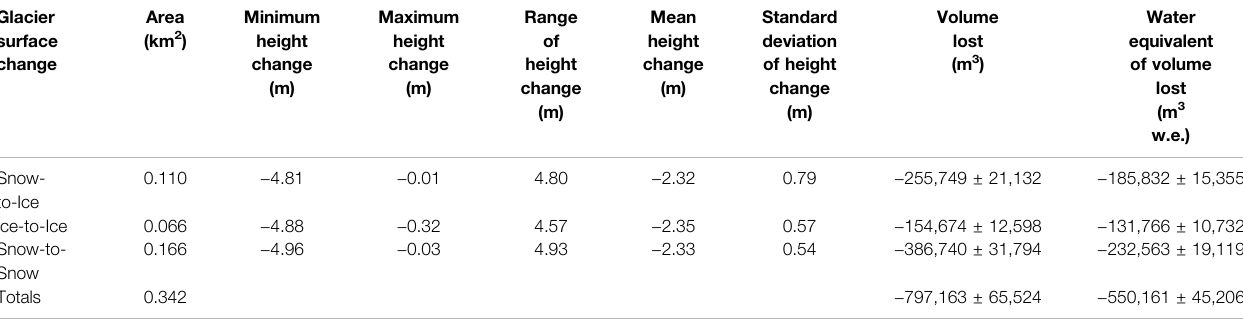
TABLE 5 | Surface height differences between the DEMs of the Wells Creek drainage basin portion of the Sholes Glacier on August 17, 2020 and September 5, 2020. The surfaceheightchangesareseparatedintothreesurfacetypeclassesbasedontheIsoDataunsupervisedclassi fi cation.Statisticswerecalculatedbasedoneachsurface type